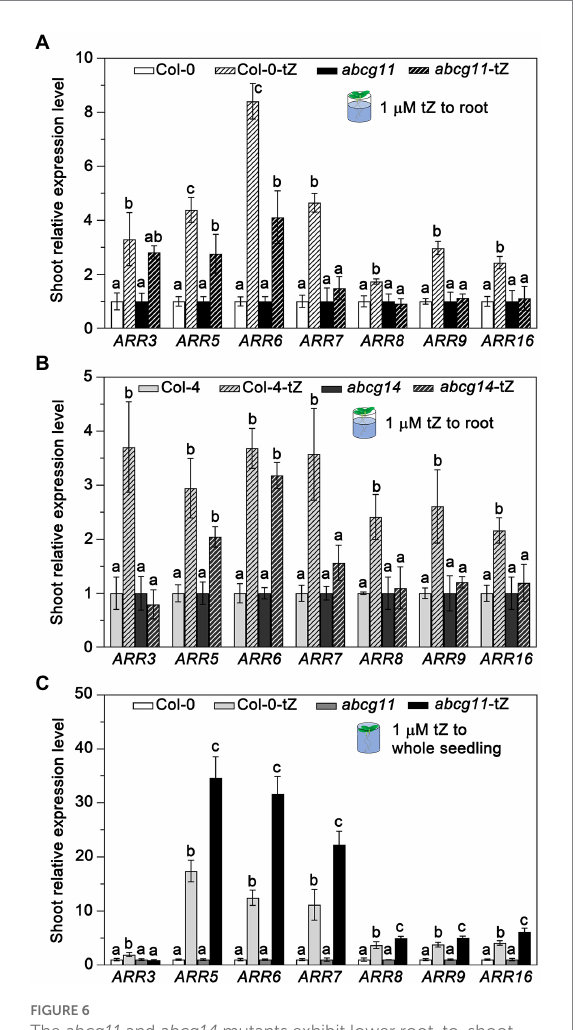
FIGURE 6 The abcg11 and abcg14 mutants exhibit lower root-to-shoot transfer of cytokinin signaling. (A,B) Relative expression levels of type-A ARR s in the shoots of Col-0 and abcg11 (A) , and Col-4 and abcg14 (B) . Only the roots of 12-d-old seedlings were soaked in half-strength MS medium or half-strength MS medium containing 1 μ M trans -zeatin (tZ) for 1 h. The shoots were harvested for analysis of ARR expression levels. (C) Relative expression levels of ARR s of Col-0 and abcg11 after tZ treatment of whole seedlings. The 12-d-old seedlings were submerged in 1 μ M tZ for 30 min. TUBULIN8 served as an internal control; values in Col-0 and abcg11 under control conditions were set to 1. Data are shown as means ± SE ( n = 4). Different letters in (A) , (B) , and (C) indicate significant differences in gene expression levels, as determined by one- way ANOVA ( p <